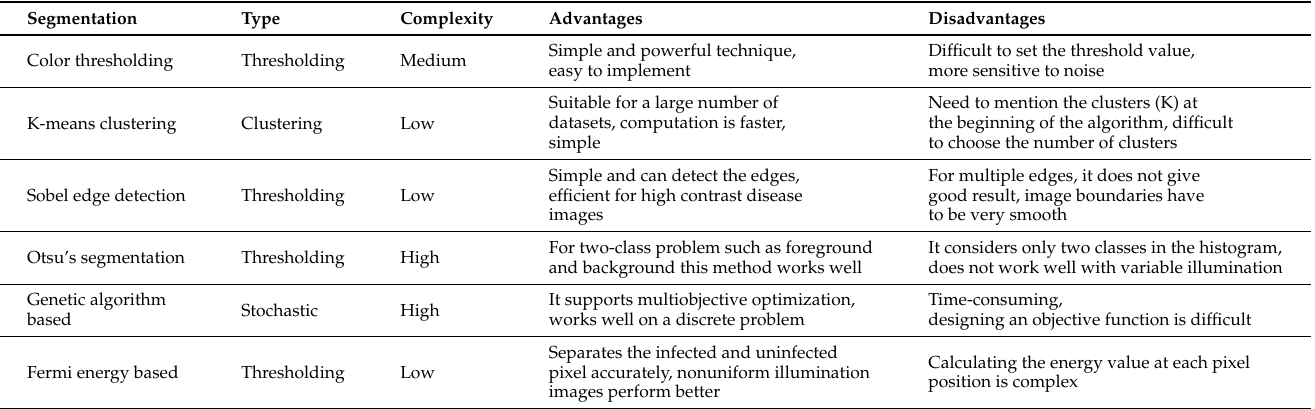
Table 3. Summary of different image segmentation